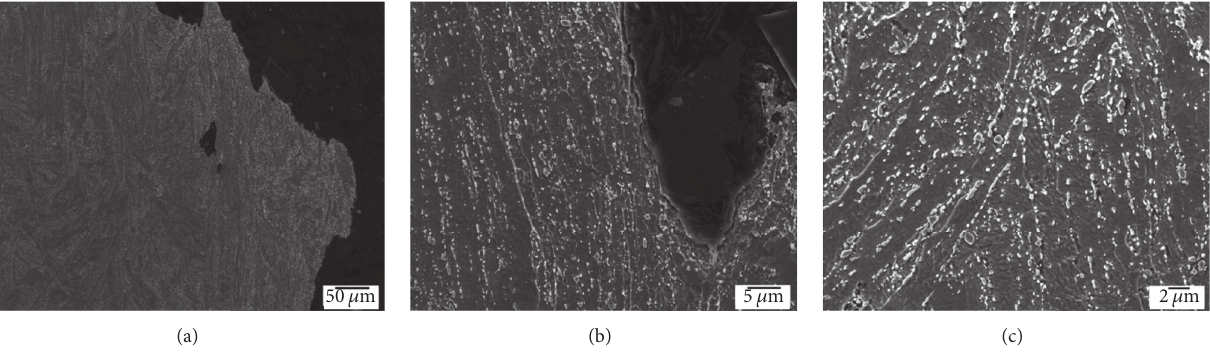
Figure 16: Fracture path (a, b) and creep cavity (c) analyses of CB2 BM specimen ruptured by high deformation shear failure after the creep test at 625 ∘ C, 120